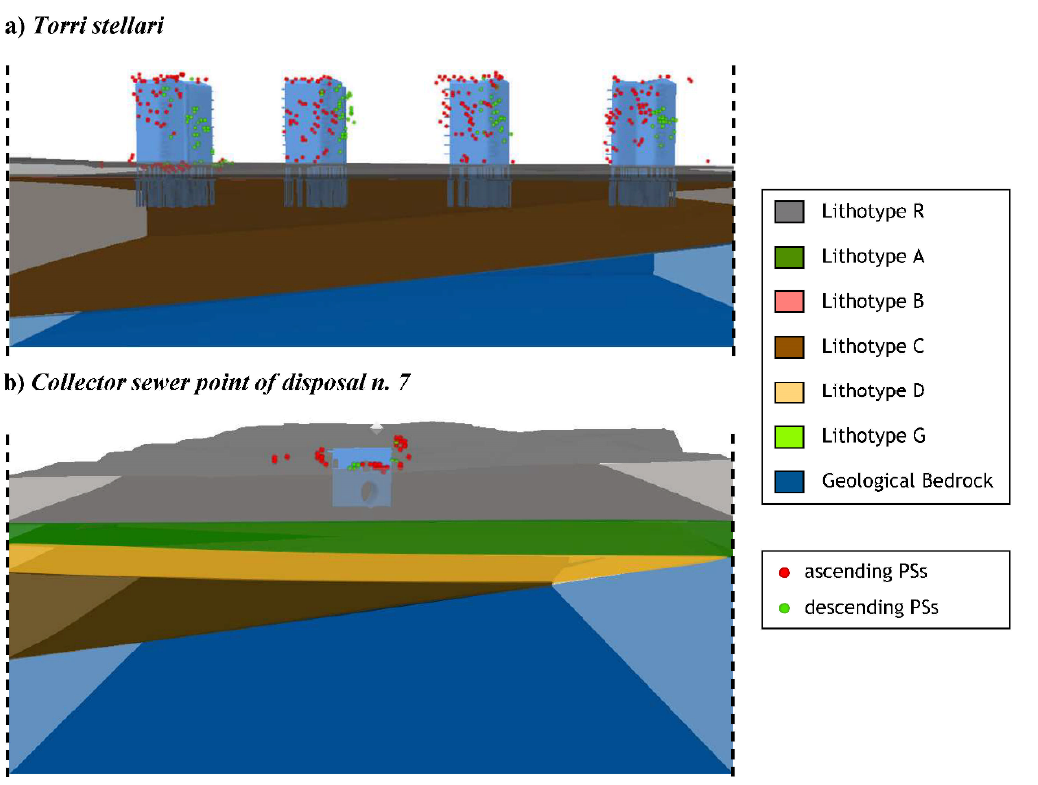
Figure 10. Three-dimensional integrated models: ( a ) Torri Stellari complex and ( b ) Collector sewer point of disposal n. 7 (red circles: ascending PSs, green circles: descending PSs). point of disposal n. 7 (red circles: ascending PSs, green circles: descending